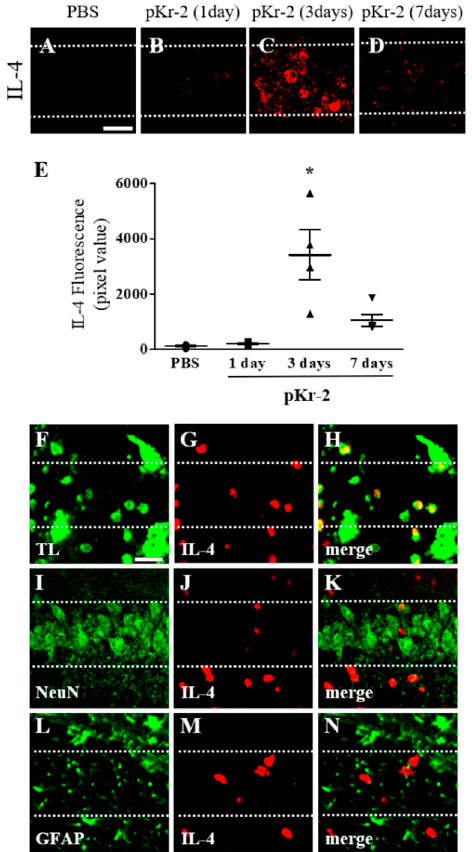
Figure 3. Expression of endogenous interleukin-4 in the CA1 layer of pKr-2-lesioned hippocampus in vivo. PBS ( A ) or pKr-2 ( B – D , F – N ) was unilaterally injected into the CA1 layer of rat hippocampus. Animals were transcardially perfused at various time points and brain sections were processed for immunohistochemical staining. ( A – E ) Immunofluorescence images of IL-4 ( A – D ) and quantification ( E ) in the CA1 layer of rat hippocampus at the indicated time points. * p < 0.001, significantly different from PBS (control). mean ± SEM; E, n = 4 to 5 in each group, ANOVA and Newman–Keuls analysis. Scale bar, 40 µ m. ( F – N ) Double immunofluorescence images of tomato lectin (TL; F , green) for microglia / macrophages and IL-4 ( G , red) or neuronal nuclei (NeuN; I , green) for neurons and IL-4 ( J , red) or glial fibrillary acidic protein (GFAP; L , green) for astrocytes and IL-4 ( M , red) and both images are merged (yellow; H , K and N ) in the CA1 layer of hippocampus at 3 days after pKr-2 injection. Scale bar, 25 µ m. These data are representative of four to five animals per group. Dotted lines indicate the CA1 layer of the hippocampus.